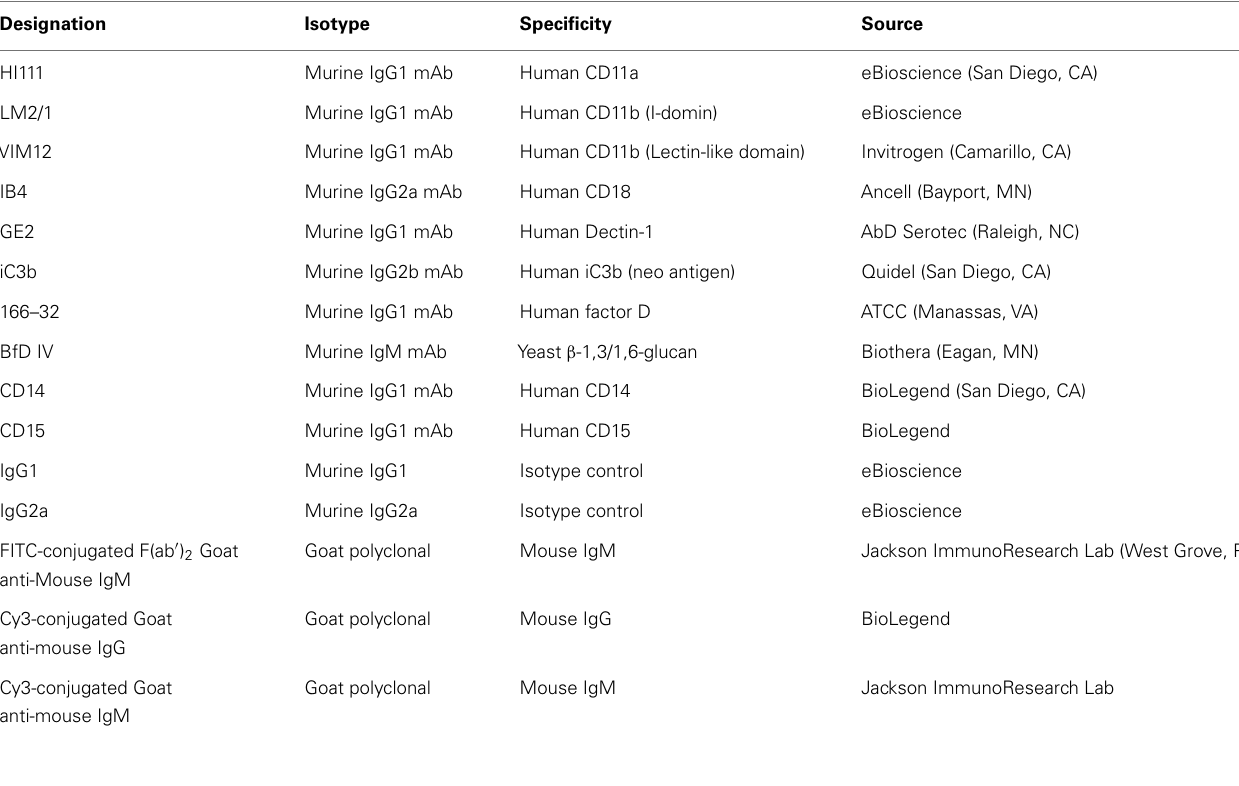
Table 1 | Description of antibodies used in the